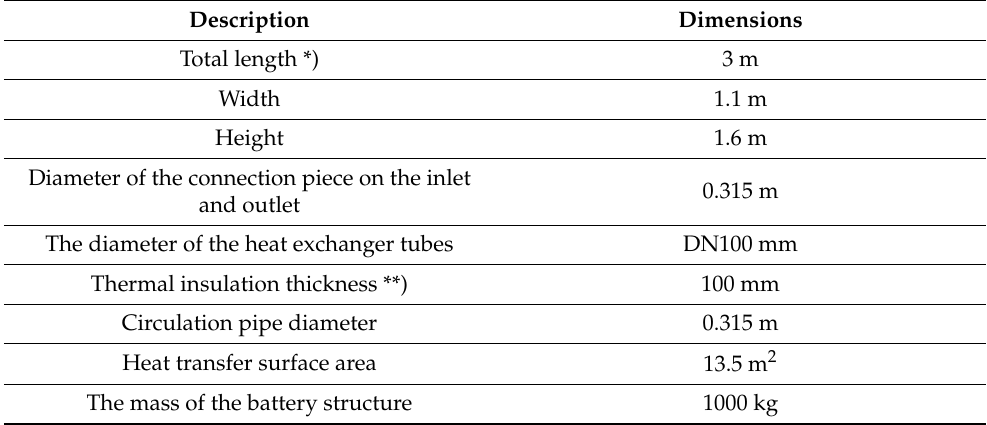
Table 1. Technical specification of the PCM battery (the design of the PCM battery was developed by the authors of this